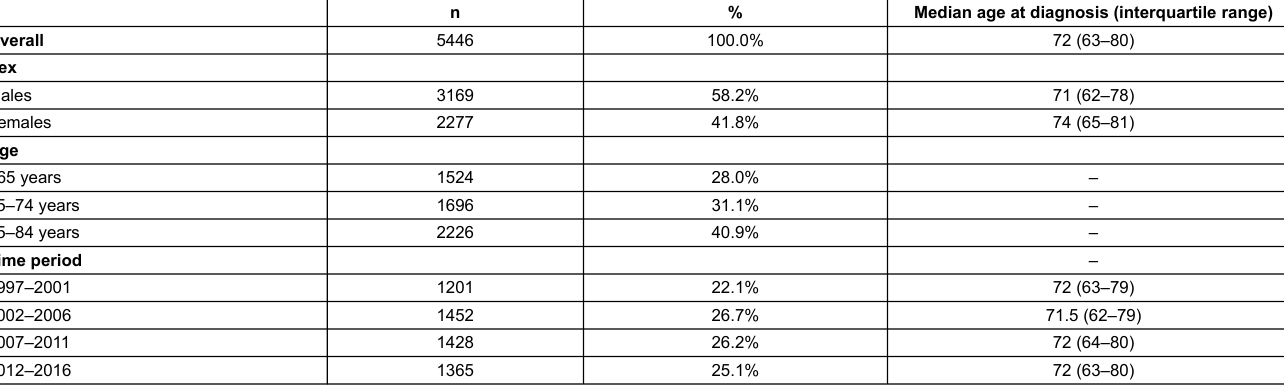
Table S6: Patient characteristics of chronic lymphocytic leukaemia / small lymphocytic lymphoma cases reported to Swiss cancer registries, 1997–2016 (sensitivity analyses). n %